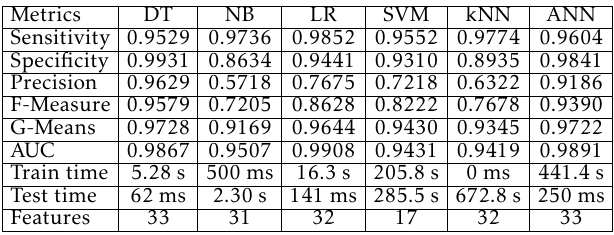
Table 19. Results of using IG-BFE on RECONNAISSANCE. Metrics